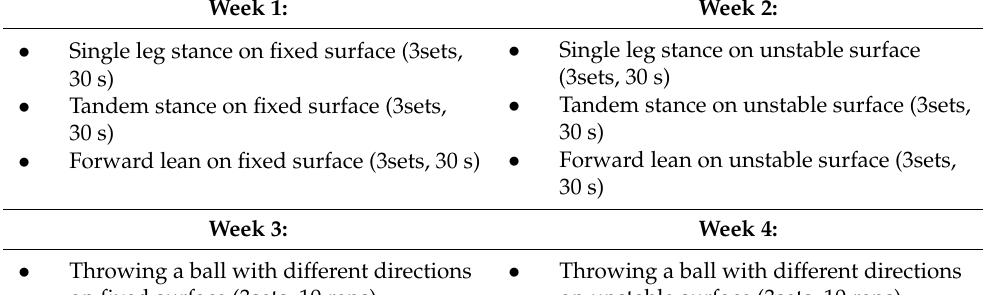
Table 1. Sensorimotor training program † .